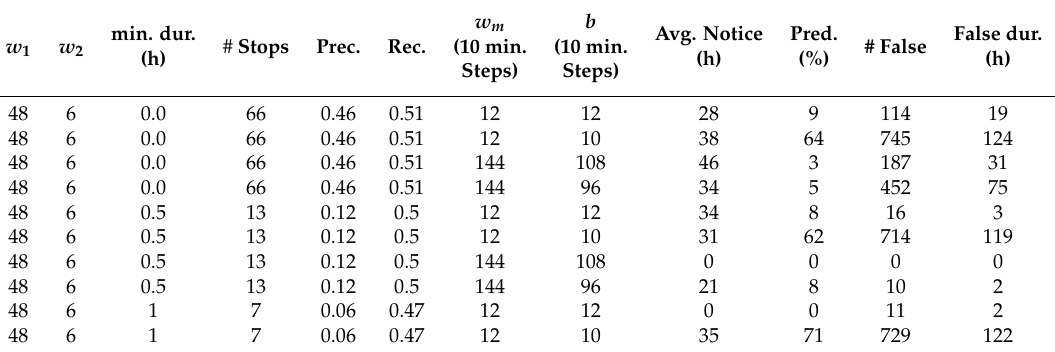
Table 5. Results of alarm system